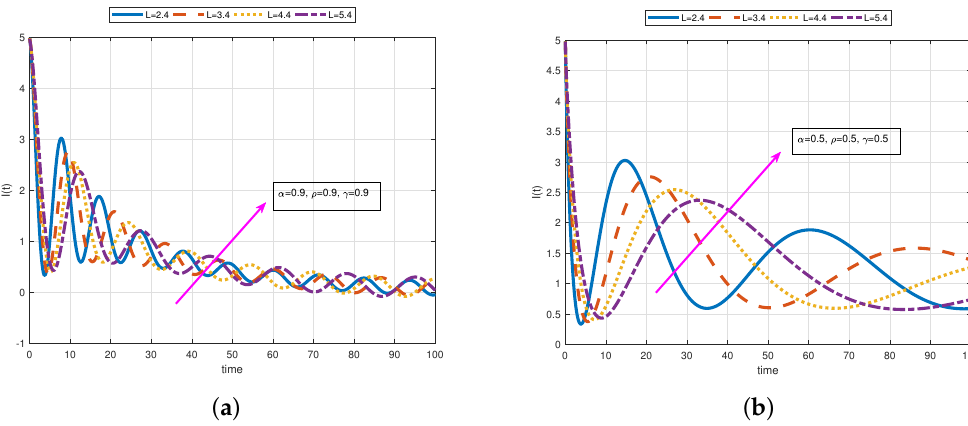
Figure 11. The figure ( a ) corresponds to the solution Equation (31) containing exponential source for various values of α , ρ , and γ in order to see the effect of parameter L when C = 0.5 F, λ = 0.05, e 0 = 5 V, and I ( 0 ) = 0, and similarly the figure ( b ) is plotted to show the effect of L on solution curves when C = 0.5 F, λ = 0.05, e 0 = 5 V, and I ( 0 ) = 0.